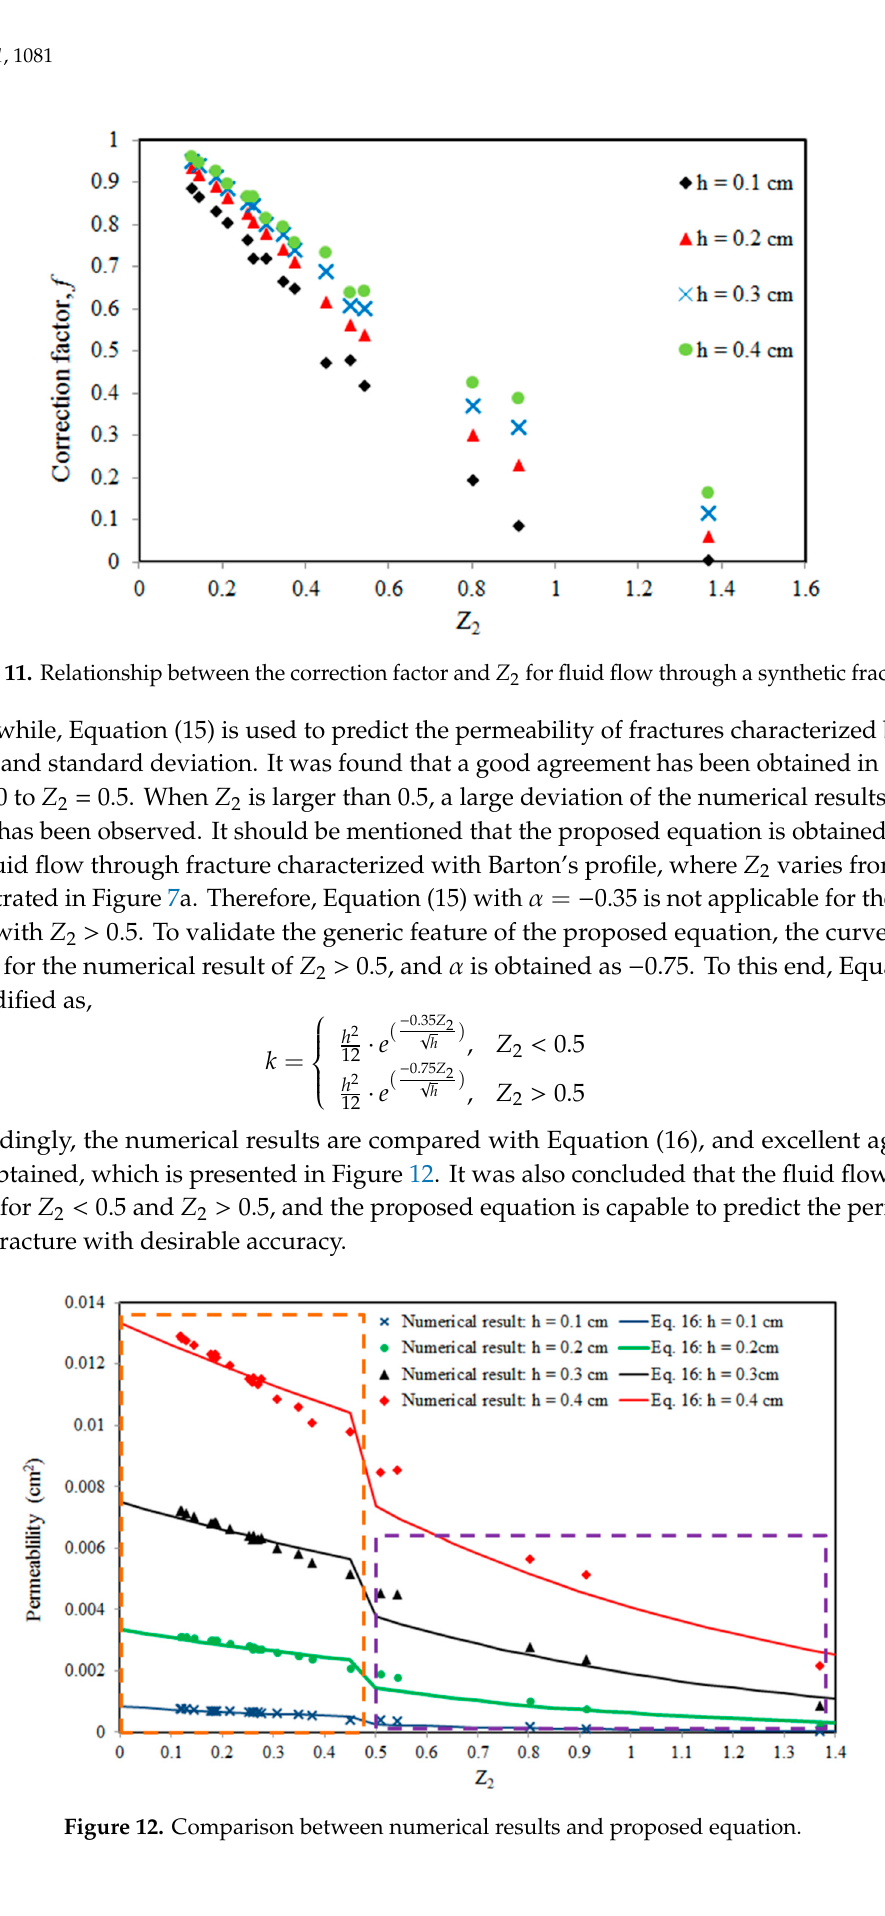
Figure 10. Relationship between Z 2 , fractal dimension and standard deviation.